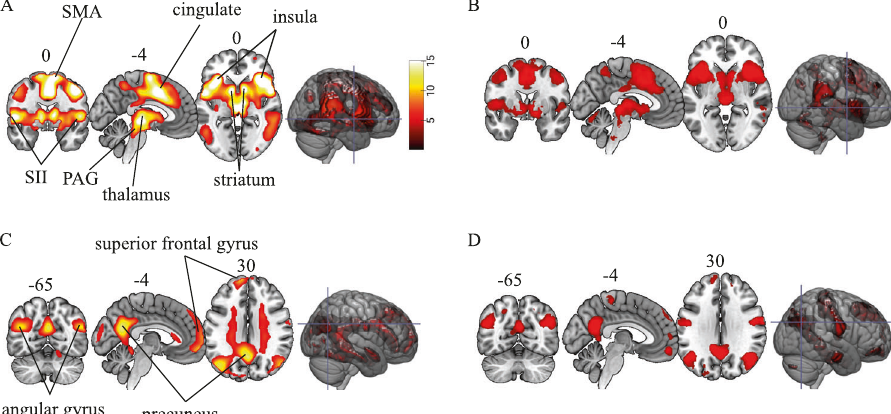
Fig. 1 Functional activation during fear conditioning. A Activation map depicting brain activity during fear learning ( P < 0.05, FWE corrected). Activated regions included bilateral insula, cingulate cortex, dorsal pons, dorsal precuneus, hypothalamus, secondary somatosensory cortex (SII), supplementary motor area (SMA), thalamus, and the ventral striatum. B The binary brain mask showing brain areas associated with fear learning in a meta-analysis of fear conditioning studies (Fullana et al., 2016) that was used in the present study to de fi ne a priori brain regions prior to the genetic modeling. C Activation map for safety learning ( P < 0.05, FWE corrected). Activated regions included the precuneus, angular gyrus, superior frontal gyrus, middle occipital gyrus, superior medial gyrus, parahippocampal gyrus, temporal pole, lingual gyrus, and the postcentral gyrus. D Binary mask from Fullana et al. (2016) for the safety learning. Coordinates ( xyz ) are in Montreal Neurological Institute (MNI) space. Table 1. Genetic in fl uence, h 2 , on brain responses supporting fear